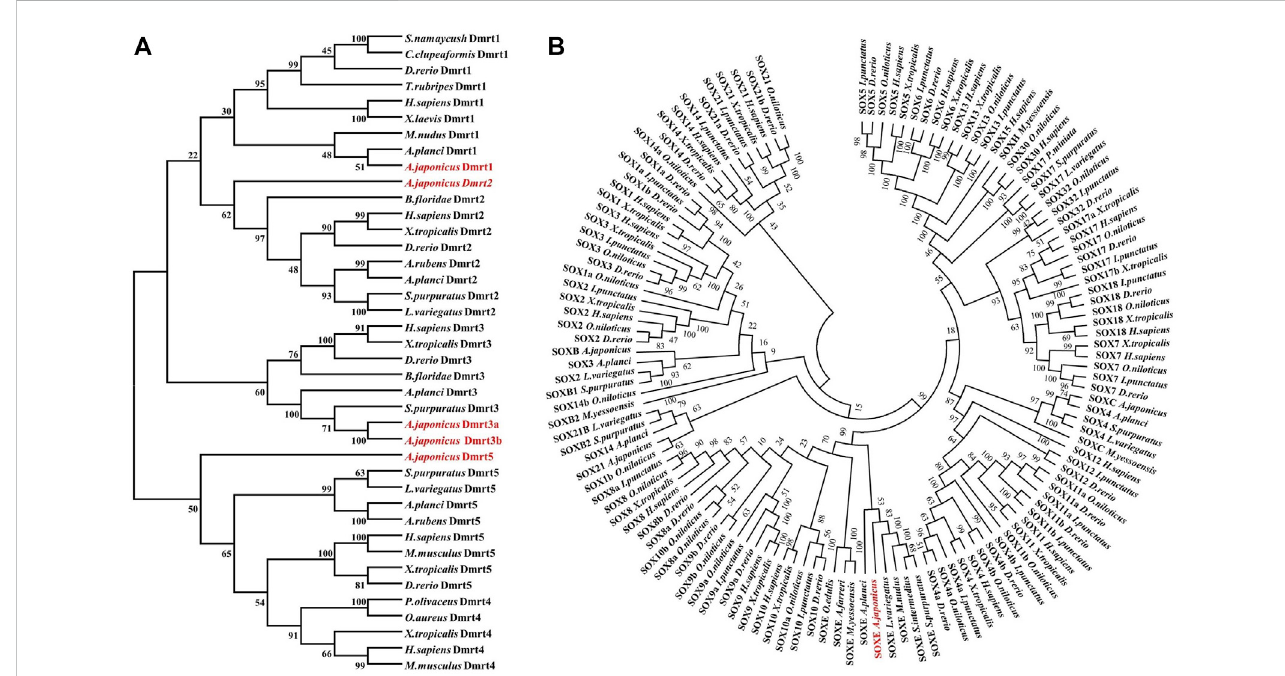
FIGURE 1 Phylogenetic analysis of the Dmrt and SOX protein family in Apostichopus japonicus (A) Dmrt. (B) SoxE. The phylogenetic tree was constructed with MEGA version 7.0 (1,000 replicates) by maximum likelihood